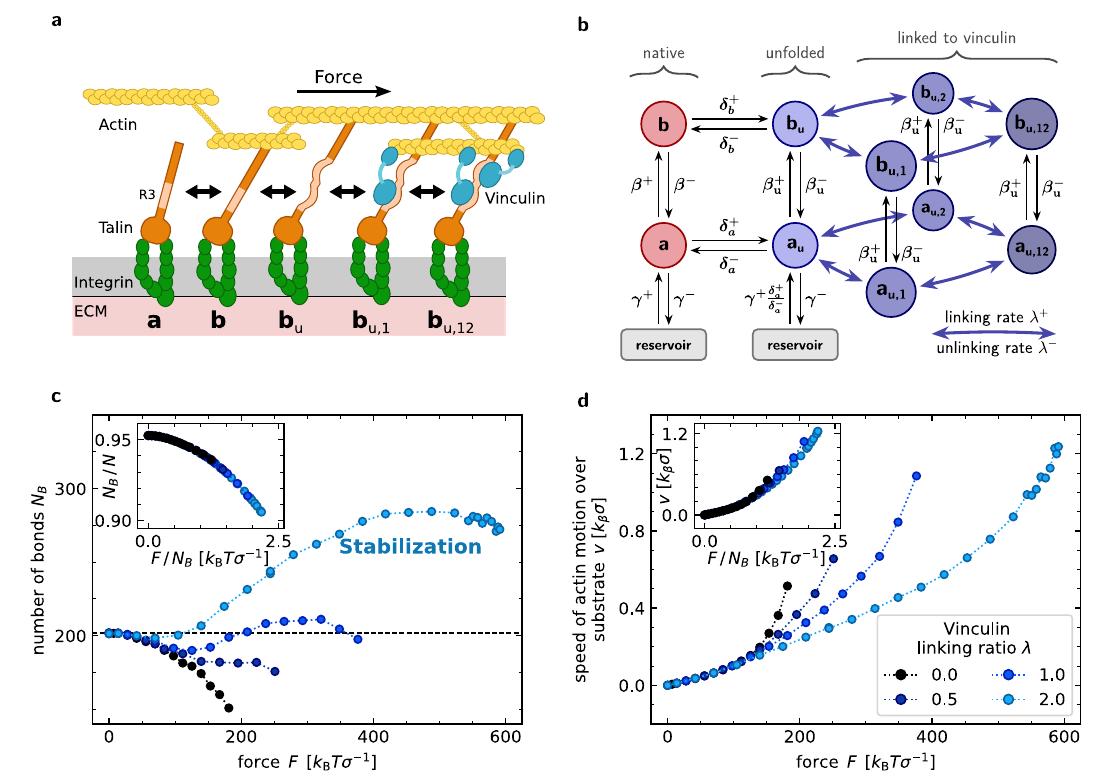
Fig. 5 Exemplary realization of self-stabilization in focal adhesions. a Talin binds with its globular head to integrins and with its rod to actin fi laments. The fi rst domain to unfold under force is the R3 domain with two vinculin-binding sites. b State diagram for the talin-vinculin model. Averaged steady-state simulation results for different linking ratios λ = λ + / λ − . See Supplementary Notes I for parametrization. c Vinculin recruitment produces self-stabilization. d The relative motion of the top plane, modeling actin fi bers, is reduced through vinculin-based